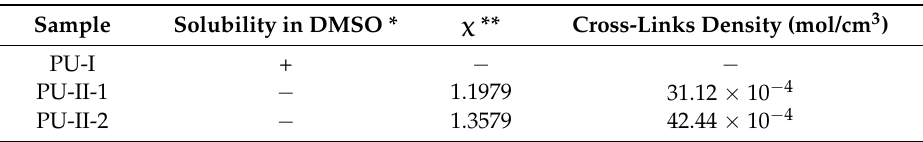
Table 3. Solubility of obtained PURs in DMSO, the Huggins parameter ( χ ) and crosslinking density (mol/cm 3 ).